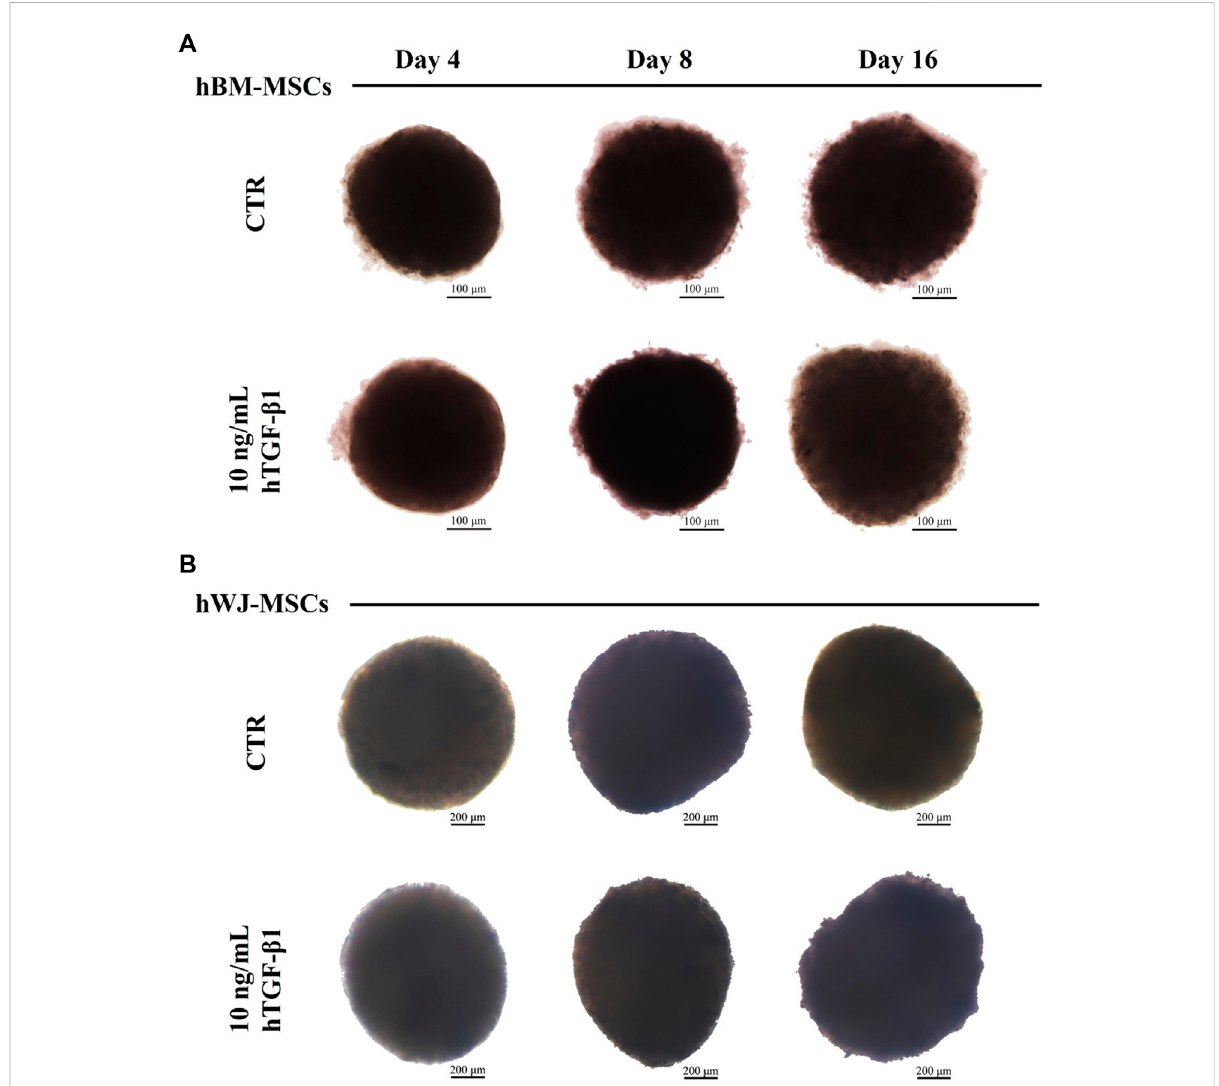
FIGURE 3 Bright fi eld images of hBM-MSCs (A) and hWJ-MSCs (B) 3D high-density culture supplemented with 10 ng/ml of hTGF- β 1 and acquired at Days 4,8,and16.Untreatedspheroids(CTR)atmatchedtime-pointswerepresentedforcontrolpurposes.Scalebarswere200micronforBMcultureand 100 micron for WJ